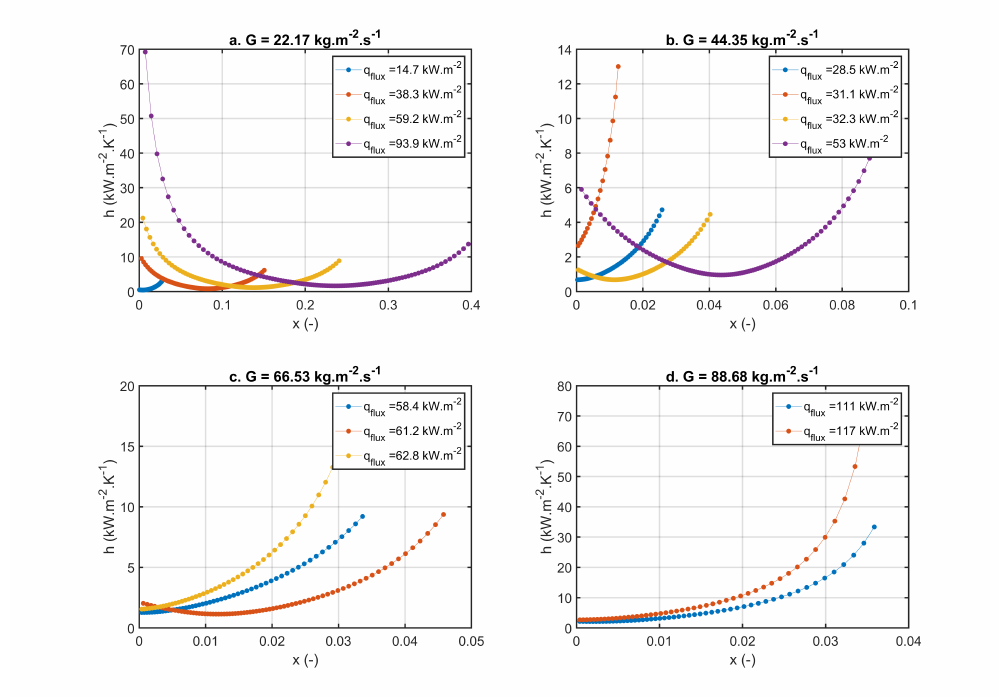
Figure 9. Local boiling heat transfer coefficient vs. vapor quality for channel 1 with fixed mass flux in each subplot for channel 1.5 mm ˆ 0.5 mm ( D h = 750 µ m). ( a ) G = 22.17 kg ¨ m ´ 2 ¨ s ´ 1